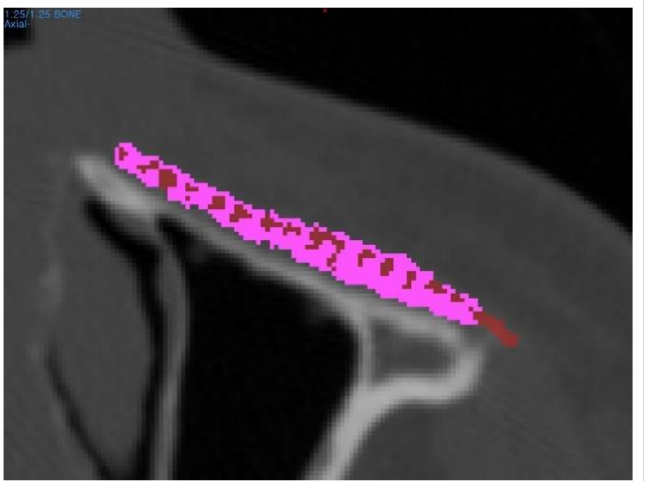
Figure 4. The bone volume fraction was defined as a ratio of the de novo bone volume to the total implant volume within the region of interest. Red area notes the region where the tissue density was measured over 200HU, while the purple area denotes the PCL/ β -TCP scaffold.